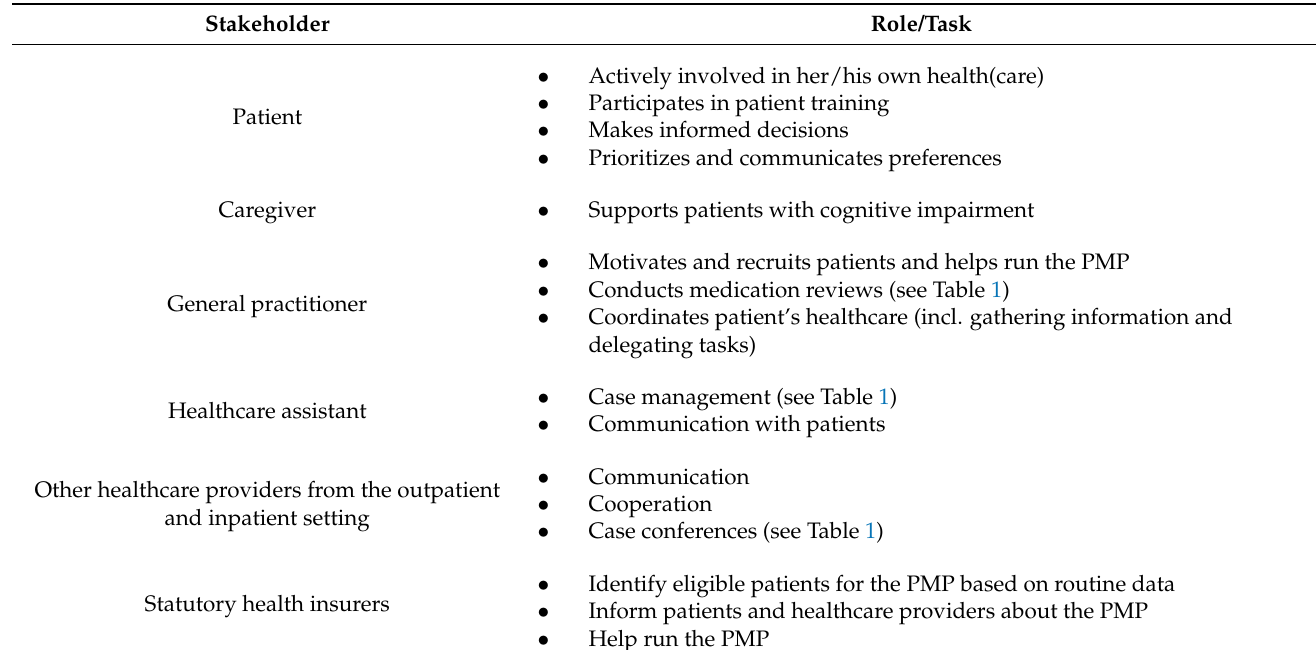
Table 3. Stakeholders that should be involved in implementing/conducting a PMP in clinical